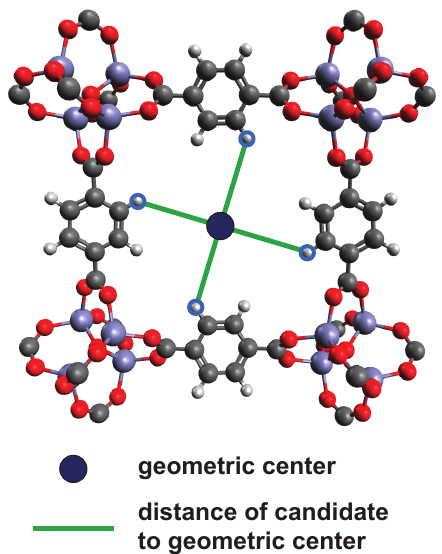
Figure 14. 2D frame of the MOF MOF-5. If there are more than two binding sites, one does not calculated the distances between any two candidates. Instead, the distance of each candidate to the geometric center is calculated. since the same applies to a cross-linker with more than two bonds, the individual distances can be